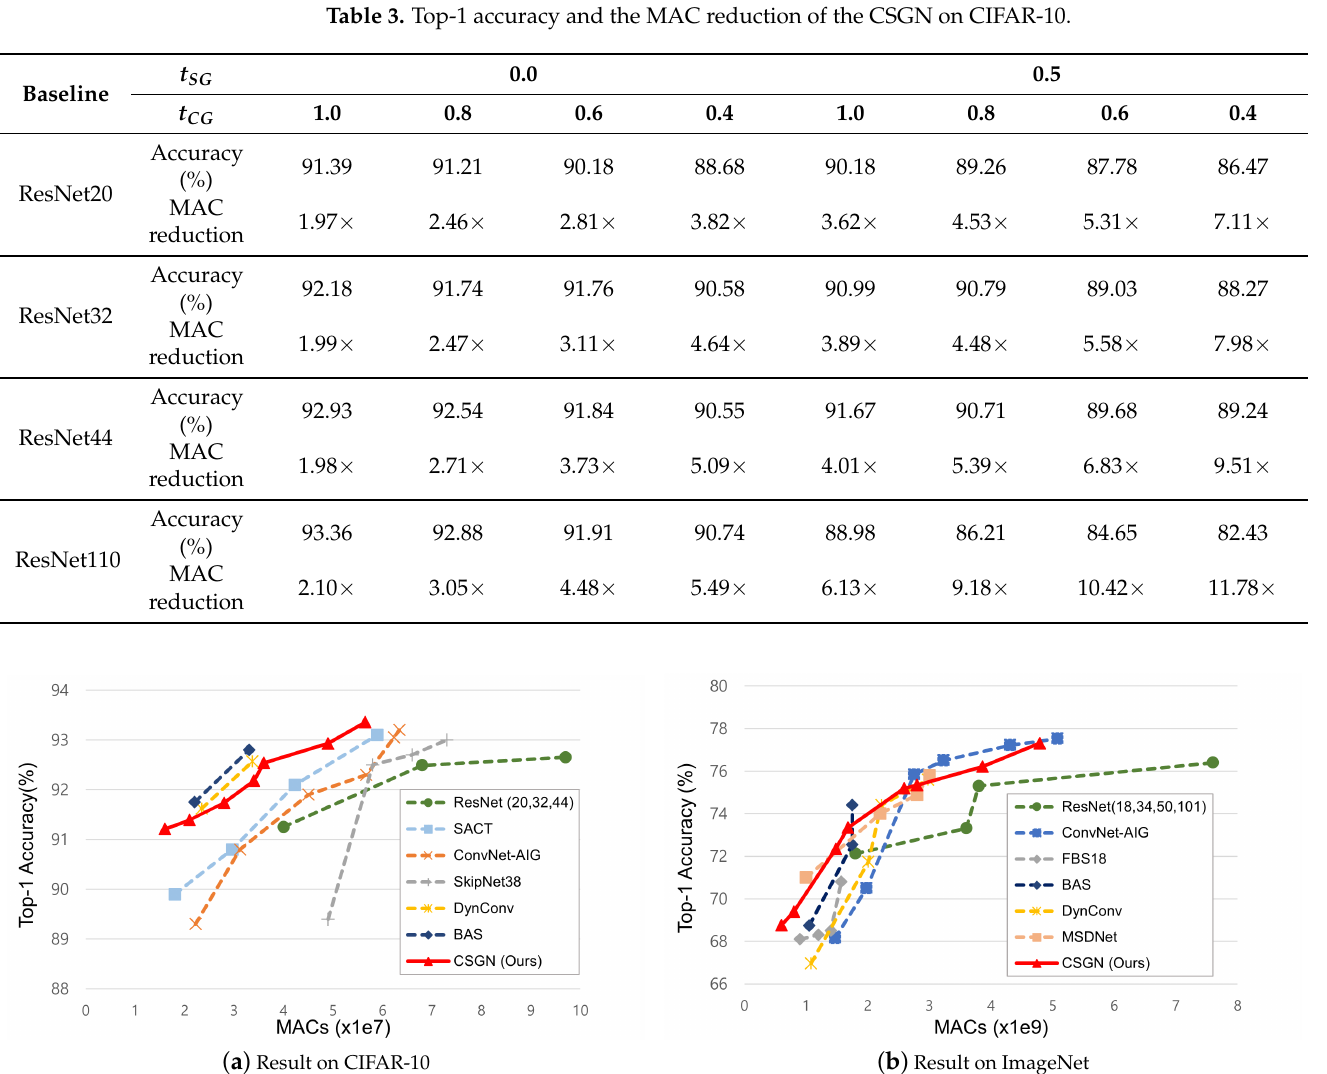
Figure 3. Performance comparison of CSGN with other gating networks on ( a ) CIFAR-10 and ( b ) ImageNet